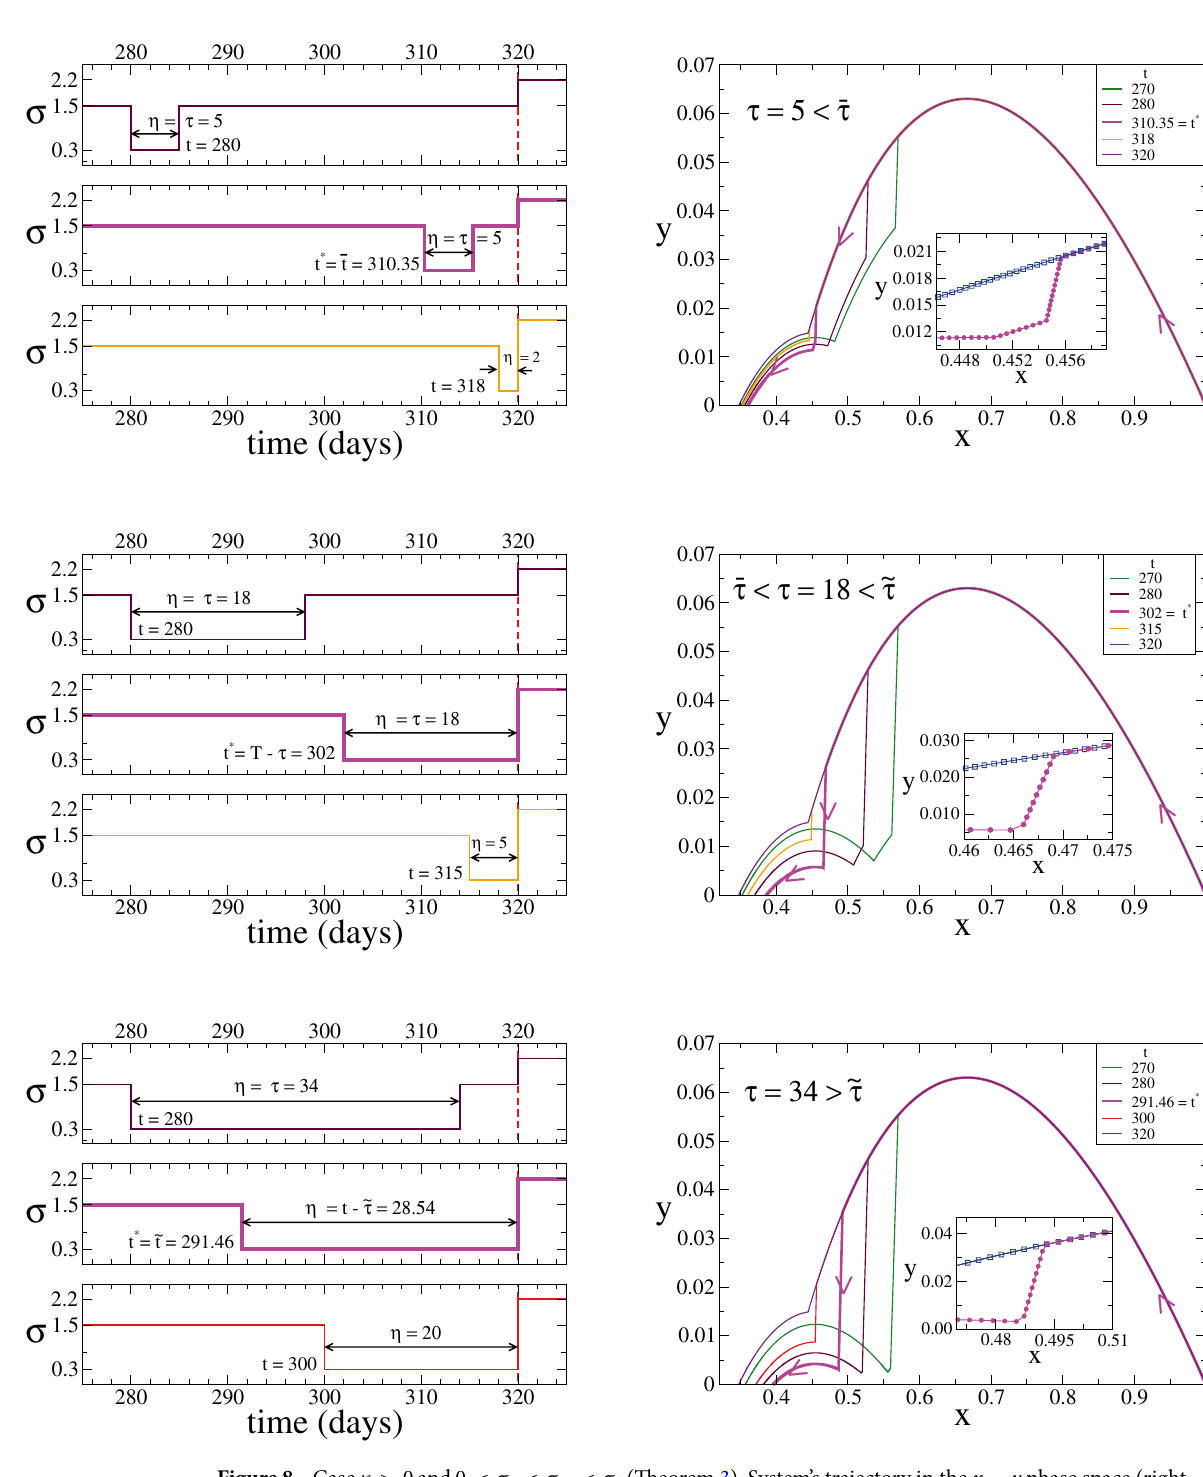
Figure 8. Case κ > 0 and 0 < σ s < σ m < σ f (Theorem 3). System’s trajectory in the x − y phase space (right panels), for γ = 0.1 , κ = 10 − 5 , σ s = 0.3 , σ m = 1.5 , σ f = 2.2 and T = 320 , and the three values of τ indicated in the legends corresponding to the different regimes of the optimum time t ∗ (pink lines). Left panels show the time evolution of σ for three different initial times t of the strict quarantine in each case. The optimum times are t ∗ = t ≃ 310.35 for τ = 5 (top panels), t ∗ = T − τ = 302 for τ = 18 (middle panels) and t ∗ = ˜ t ≃ 291.46 for τ = 34 (bottom